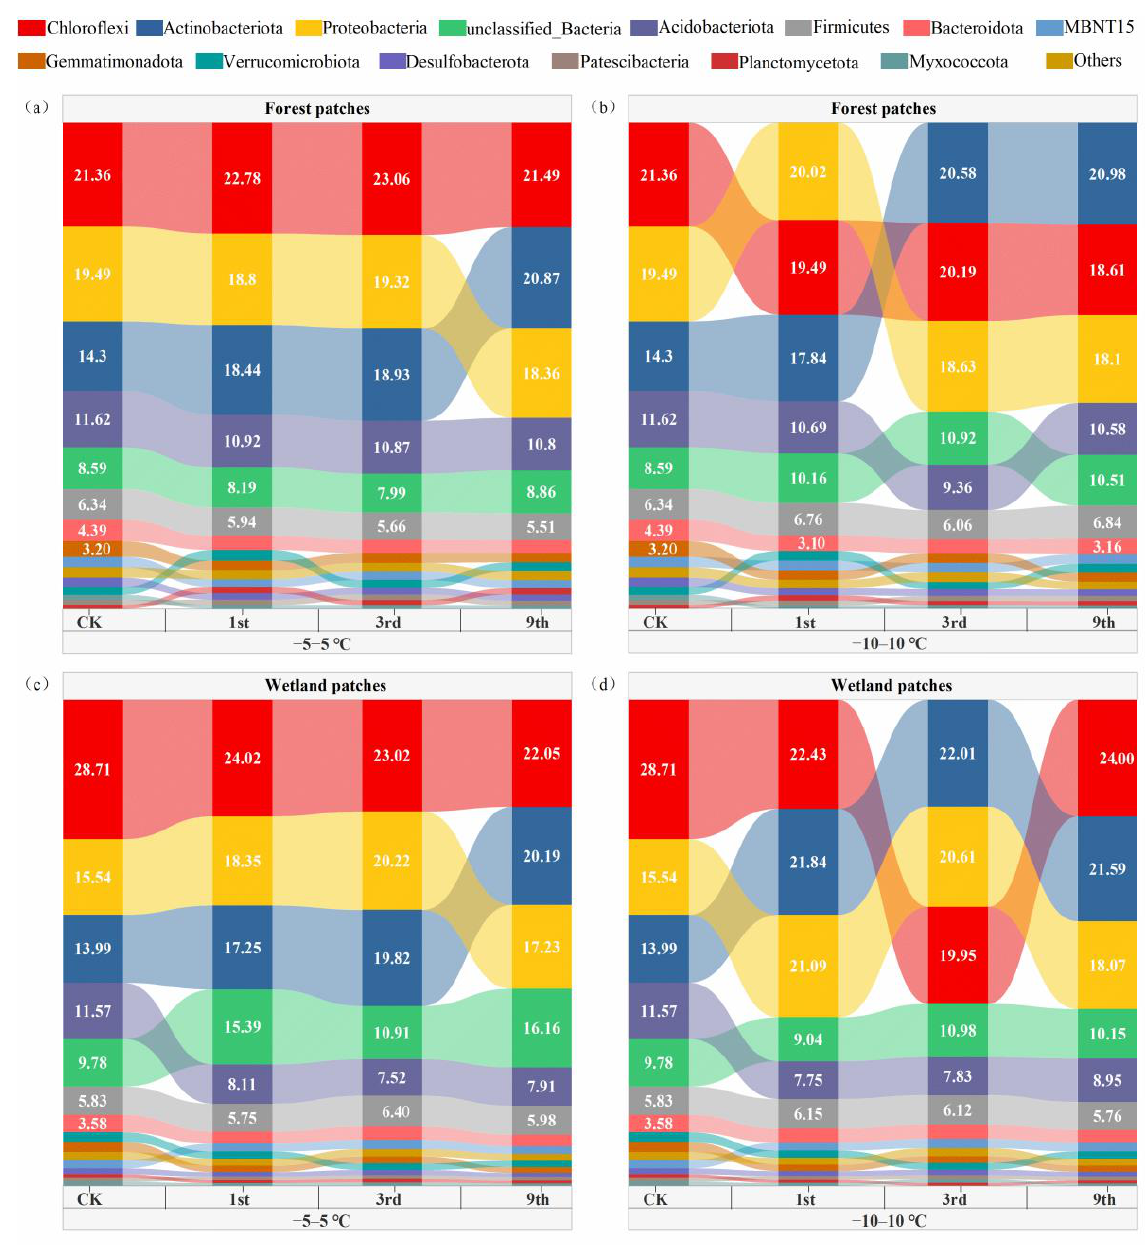
Figure 3. Relative abundance of soil bacterial phyla after FTCs. ( a ) forest patches, − 5 – 5 °C FTC treatment; ( b ) forest patches, − 10 – 10 °C FTC treatment; ( c ) wetland patches, − 5 – 5 °C FTC treatment; ( d ) wetland patches, − 10 – 10 °C FTC treatment. Values in column represent the relative abundance of bacteria on phylum level.